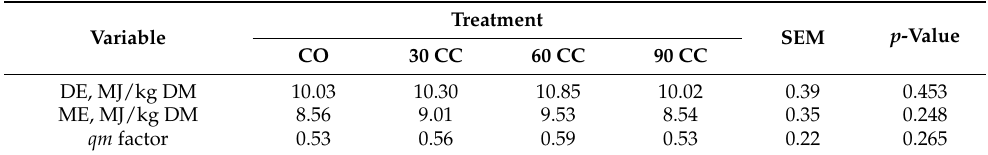
Table 4. Digestible and metabolizable energy contents and q m factors of the treatment diets supple- mented with different levels of Cymbopogon citratus .